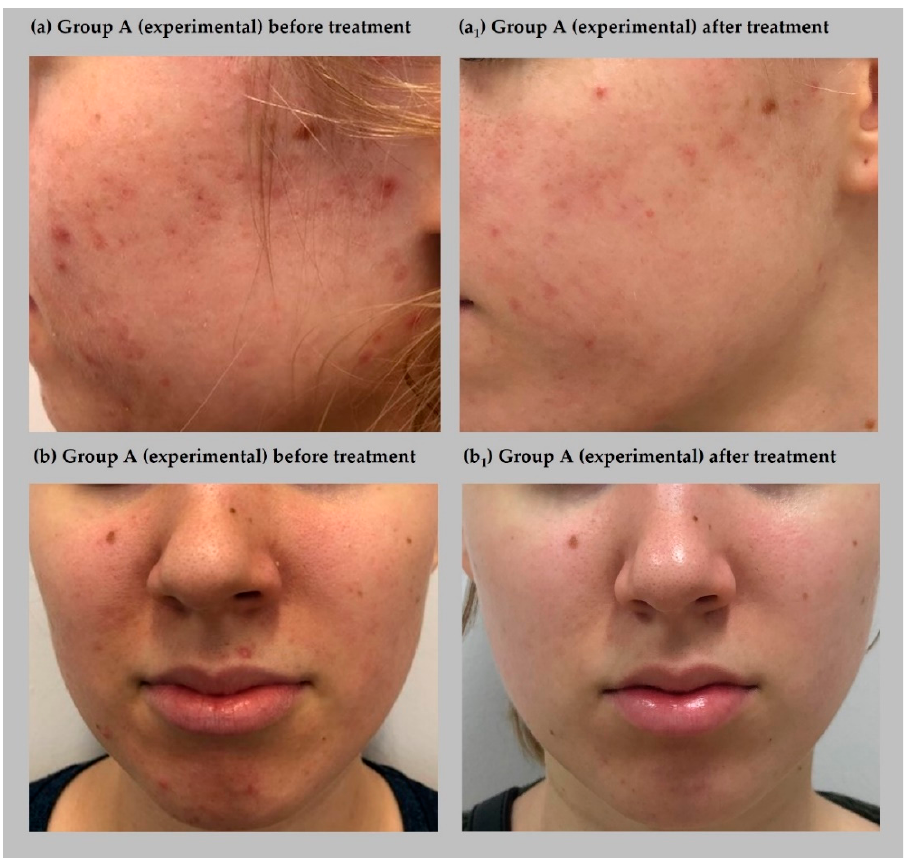
Figure 2. Effect of treatment on acne severity in two patients from group A (experimental) before ( a , b ) and after treatment ( a 1 , b 1 ).